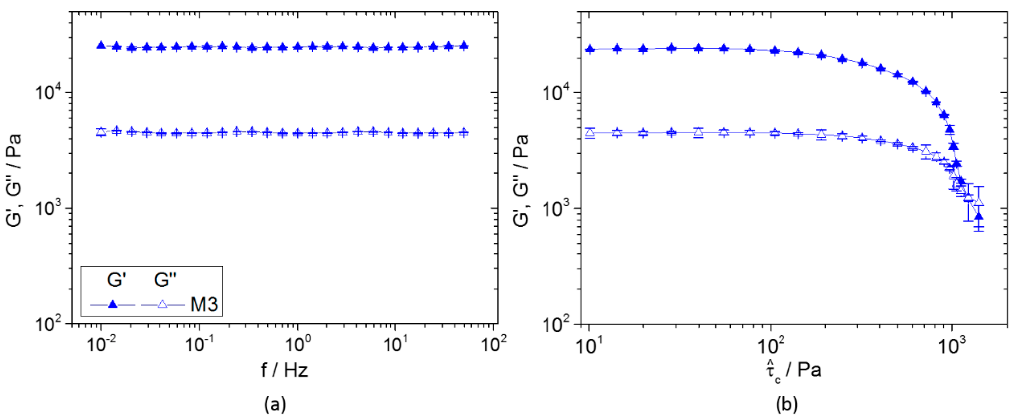
Figure A2. ( a ) Frequency sweep experiment demonstrated for M3: G ’, G ’’ vs. frequency f at fixed stress amplitude τ(cid:3548) c = 25 Pa. ( b ) Amplitude sweep experiment demonstrated for M3: G ’, G ’’ vs. stress amplitude τ(cid:3548) c at fixed frequency f = 1 Hz. Pastes M1 and M2 behave similarly.